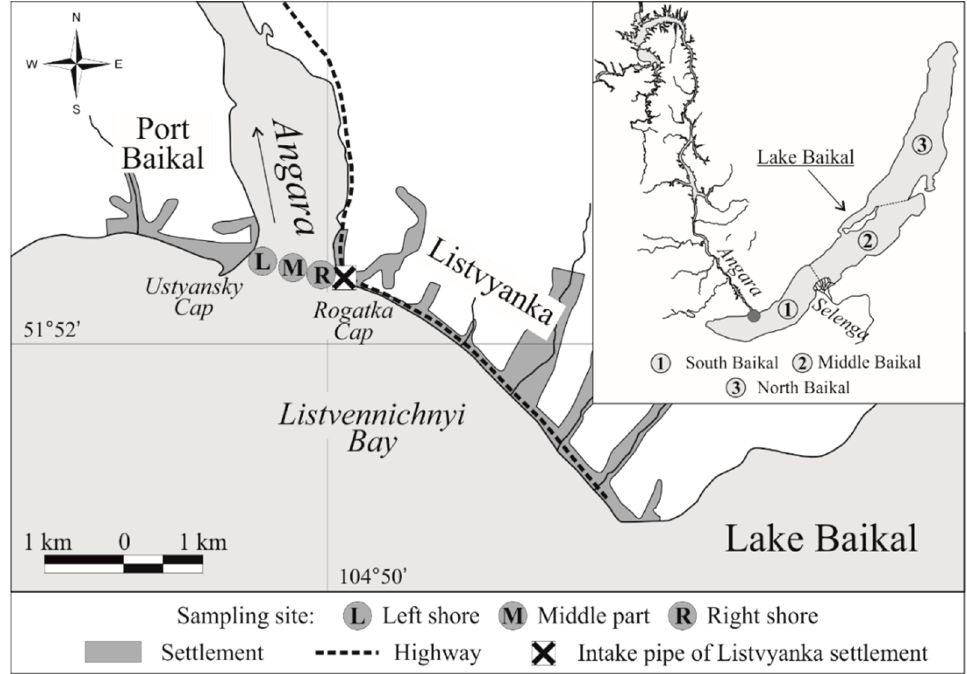
Figure 1. Study area and sampling points in the water of Angara River source.